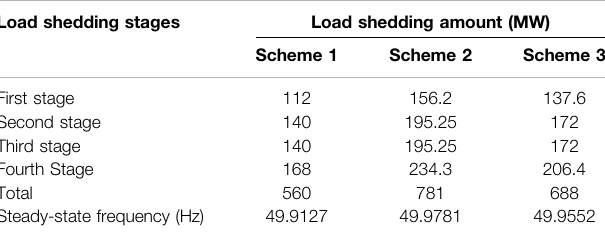
TABLE 3 | Load shedding amount and steady-state frequency of different UFLS